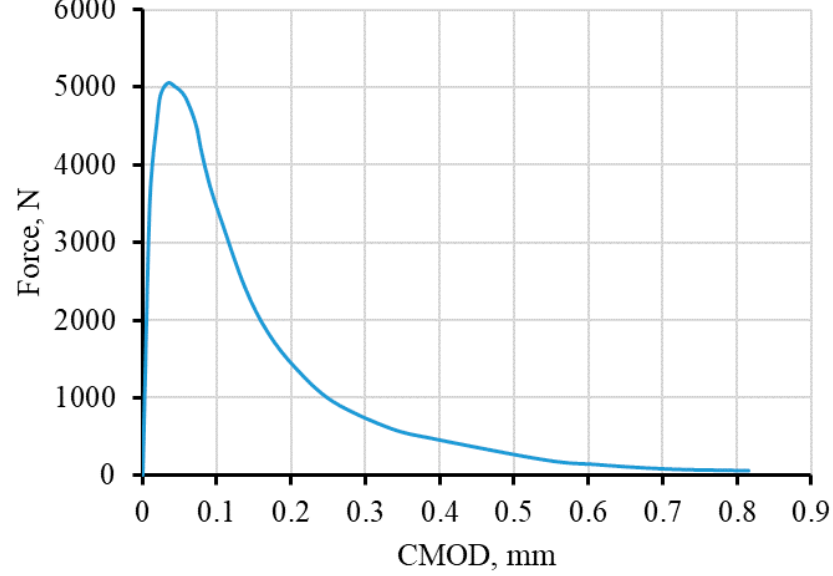
Figure 2. Force versus CMOD from bending test on non-reinforced concrete.